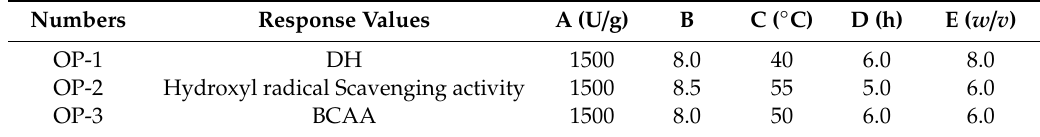
Table 1. The optimum conditions for single-factor experiments on the DH, hydroxyl radical scavenging activity, and